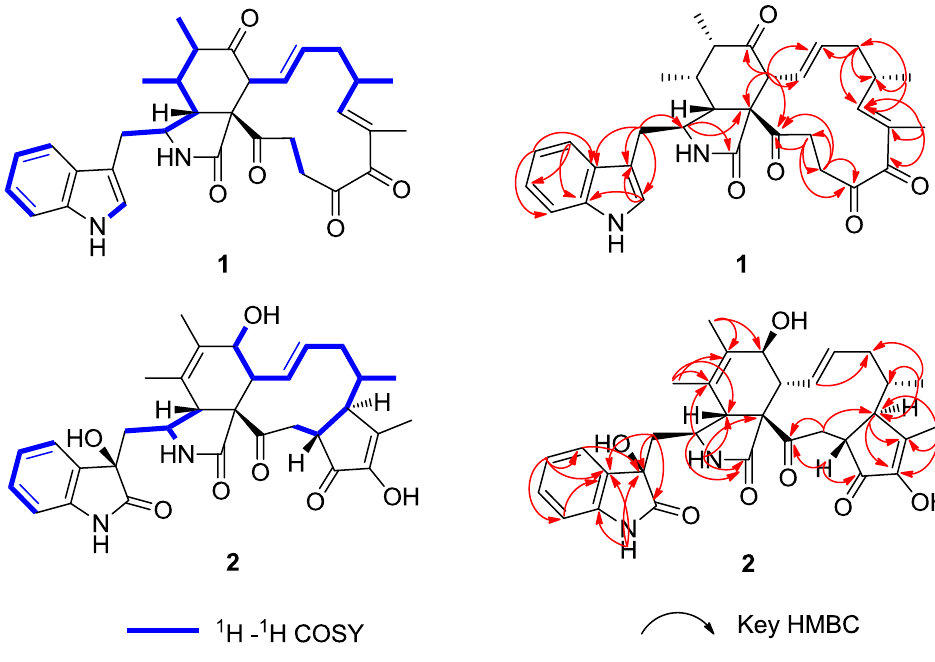
Figure 2. 1 H- 1 H COSY, Key HMBC of Compounds 1 – 2 . Molecules 2019 , 24 , x